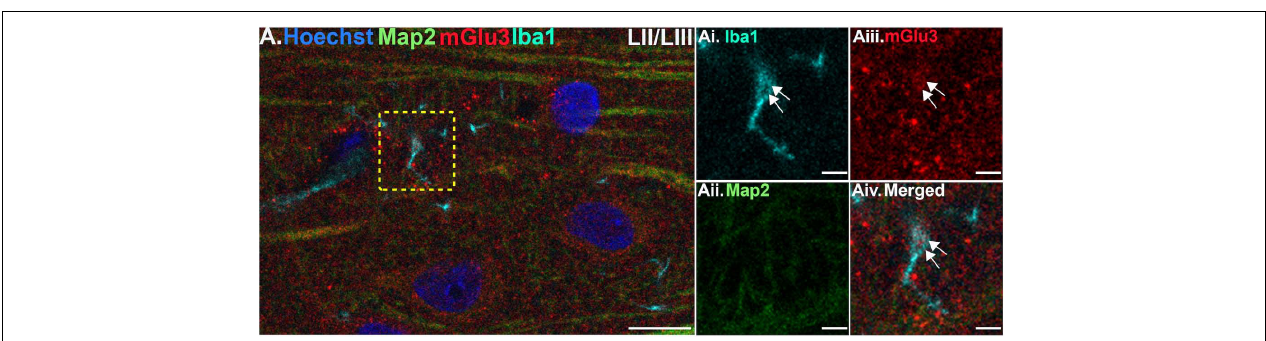
FIGURE 5 | Multiple label immunofluorescence of mGlu3 labeling in microglia in layer II/III of rat PL mPFC. Tissue was labeled with antibodies recognizing the microglial protein Iba1 (cyan), mGlu3 (red), the dendritic marker Map2 (green), as well as the nuclear Hoechst stain (blue). (A) There are diffuse Iba1 positive microglial processes across the neuropil in layer III. (Ai–iv) Magnified area of the yellow box in (A) , showing an Iba1 positive microglial process (cyan) co-localized with mGlu3 (red), indicated by white arrows. Scale bars: 10 µ m (A) , 2.5 µ m (Ai–iv)